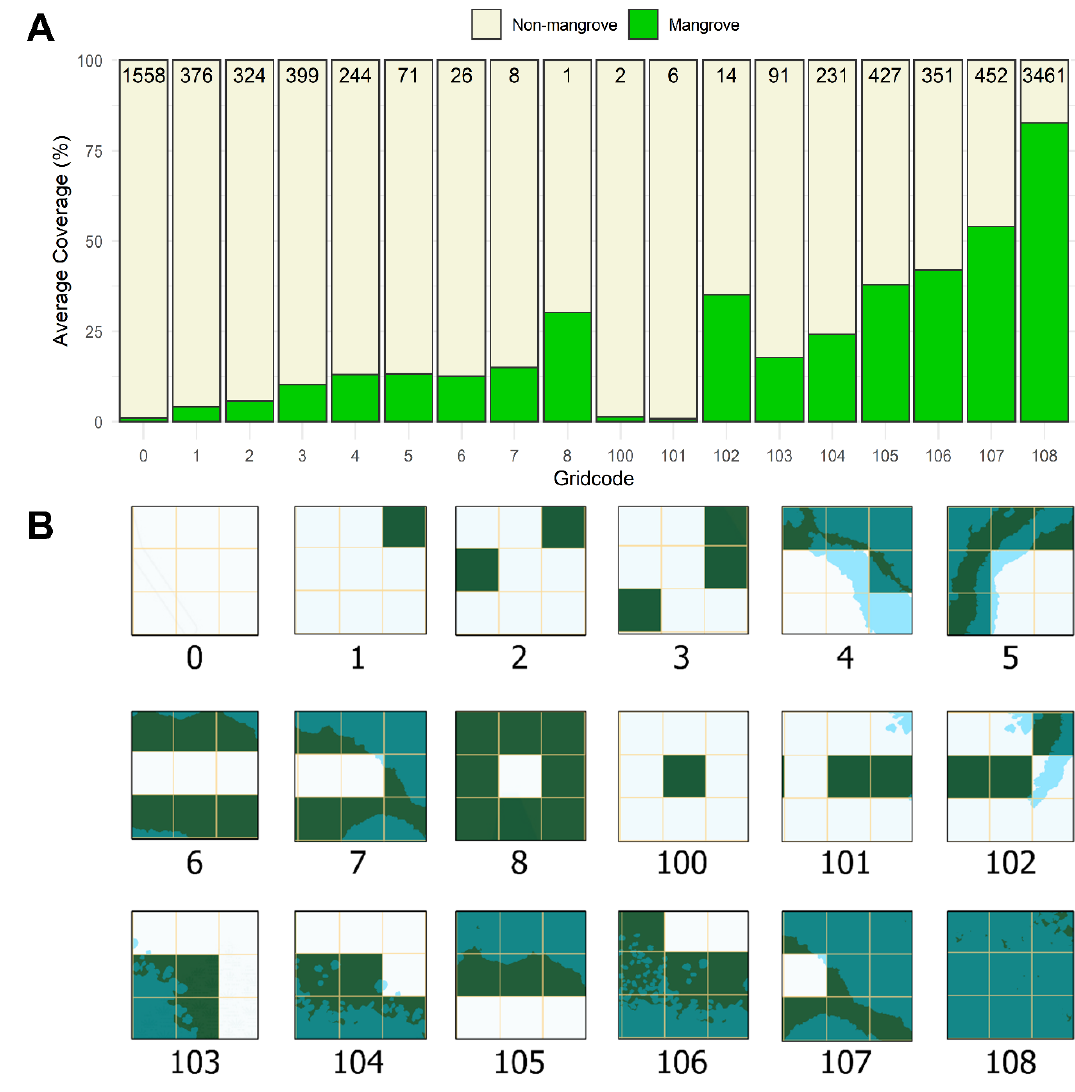
Figure 6. Mangrove and non-mangrove coverage for each gridcode category with examples. ( A ) Average mangrove and non-mangrove coverage of all cells as a percentage ( y -axis). These average values are determined by drone extents per GMW pixel for each gridcode ( x -axis). The count of GMW pixels for each gridcode is at the top of each bar. ( B ) Examples of GMW gridcodes of the center cell of each window and drone extent of mangroves detected in the area. White cells indicate non-mangrove GMW and drone classifications, green cells indicate mangrove GMW classifications, and blue indicates mangrove drone classifications. Gridcodes 0 and 108 demonstrate true positives or correct GMW classifications, while gridcode 4 demonstrates a false negative, and 102 showcases a false positive. Table 1. Table of averages for mangrove extent based on convolution analyses of GMW data.